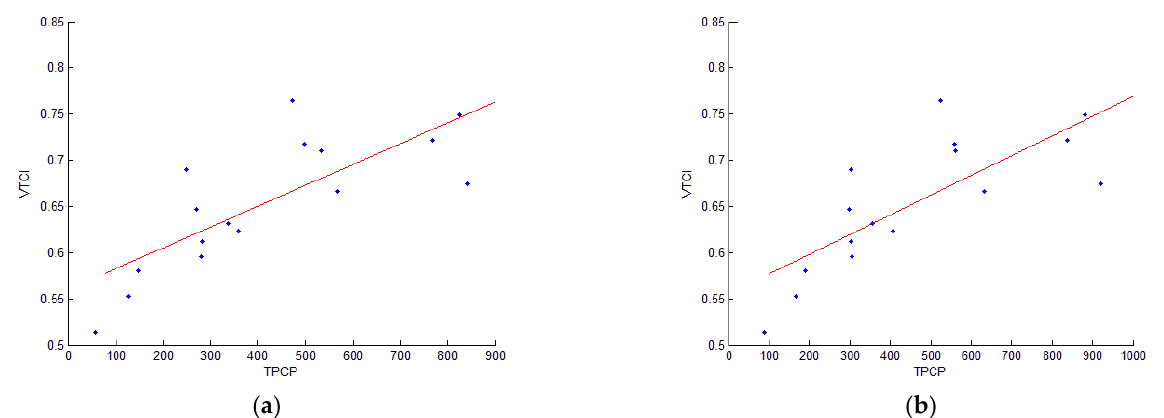
Figure 12. The linear correlation coefficient of the VTCI imagery values at D-041 during 2011 – 2014 and the TPCP anomaly at ( a ) D-288 and ( b ) D-384 during 2010 – 2014 at five stations. There are five rivers (Indus River, Sutlej, Ravi, Beas, and Chenab) passing through the plain of Punjab. Punjab’s plain is both rainfed and irrigated, while the northeastern farms are primarily rainfed for unknown reasons [64,65]. When VTCI images are combined with daily precipitation data, a clear picture of precipitation anomalies may be highlighted.